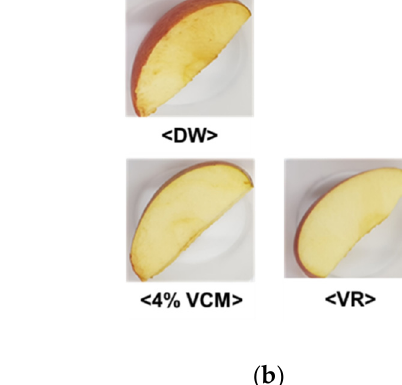
Table 2. Changes in the pH, Brix, and acidity of freshly cut apples.